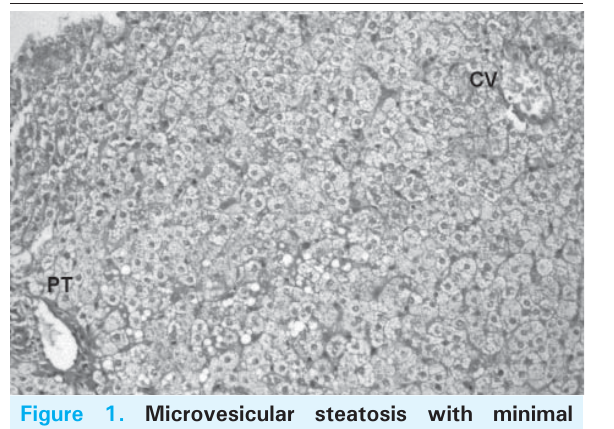
Figure 1. Microvesicular steatosis with minimal in fl ammation. PT, Portal tract. CV, Central vein. H